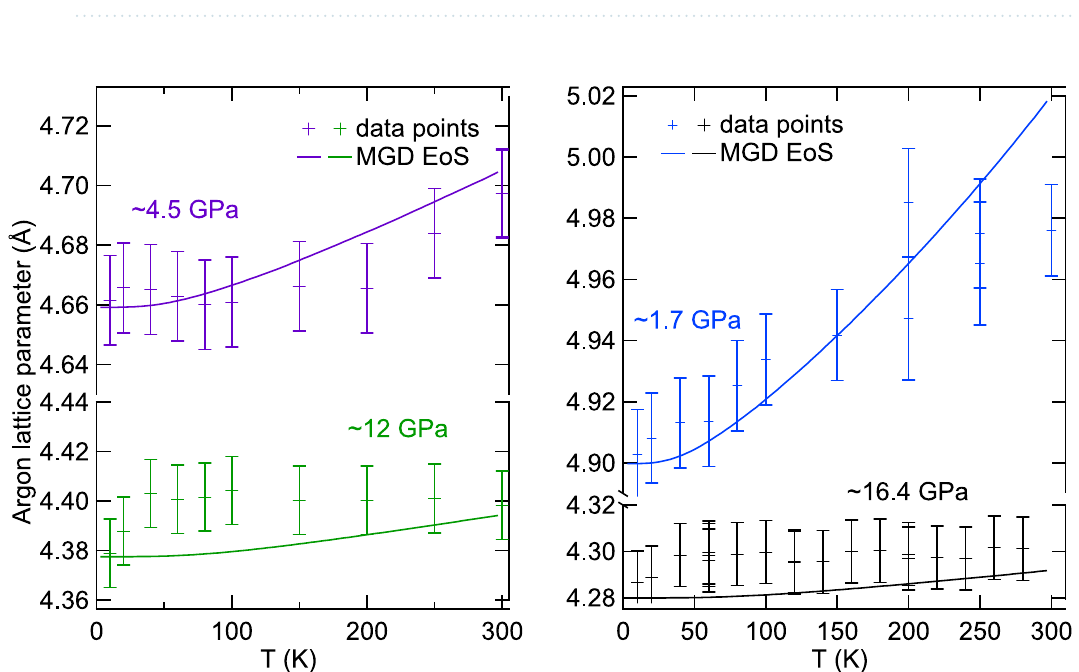
Figure 8. Thermal expansion of fcc-Ar. Argon lattice parameter has been measured vs temperature along four isobars at 1.7 GPa, 4.5 GPa, 12 GPa and 16.5 GPa. The crosses are data points, slightly modified ∼ ∼ ∼ ∼ to correct measured pressure variations (± 0.5 GPa). Continuous lines are the Mie–Grüneisen–Debye (MGD) model described in the text and Table